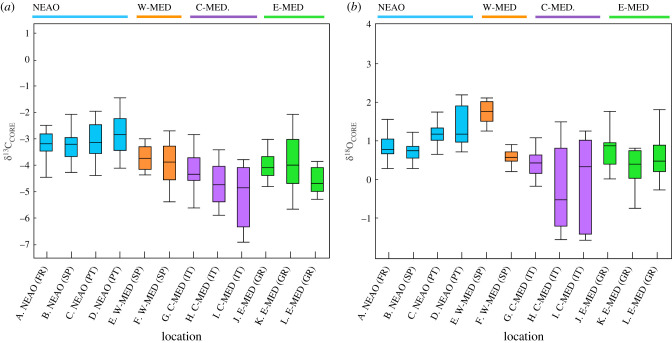
Box plot of cuttlebone (a) δ13CCORE and (b) δ18OCORE values by site and region for Sepia officinalis. Different colour box plots shown for the four major regions.